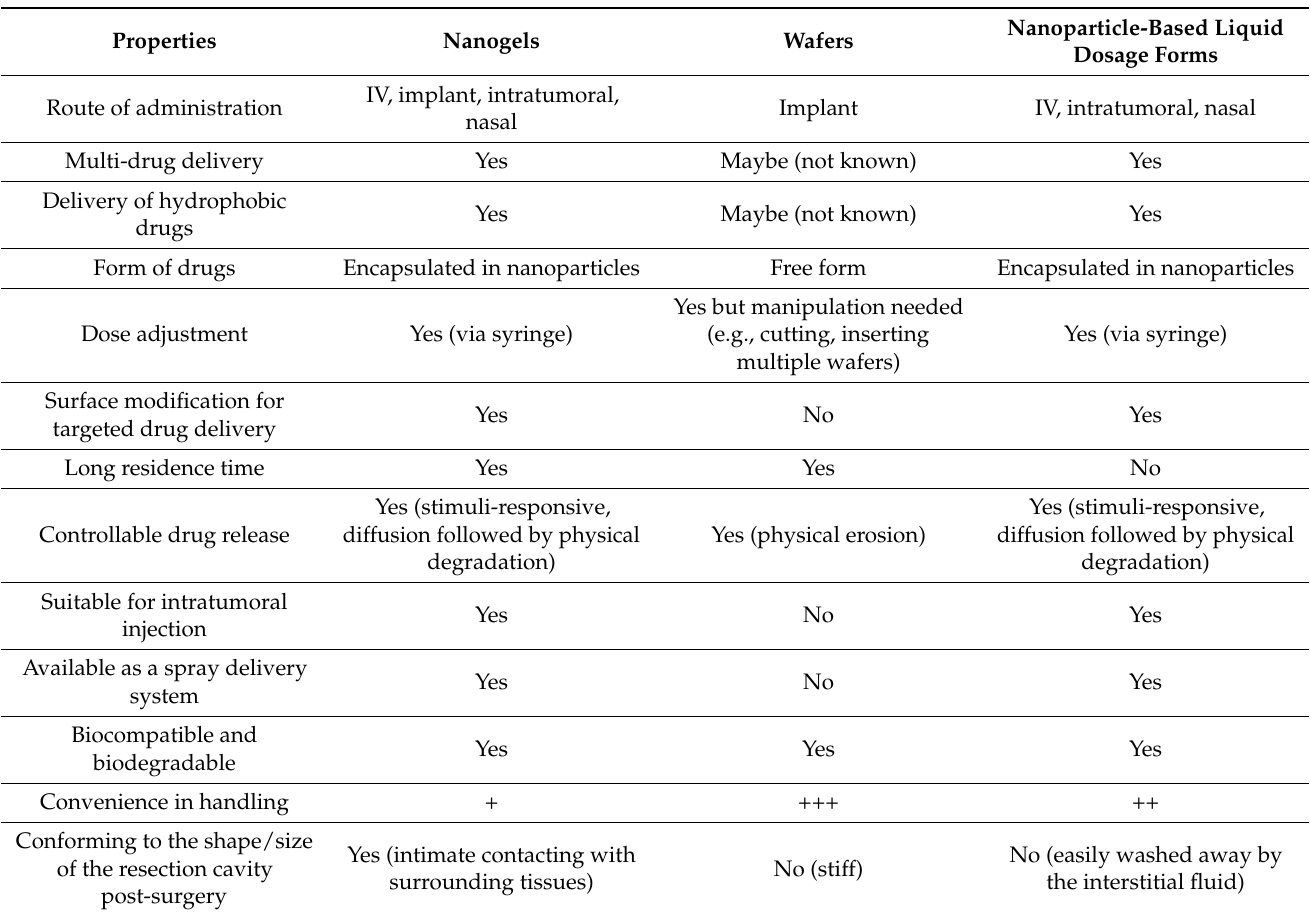
Table 2. Comparison of nanogels, wafers, and liquid dosage forms for their properties as drug delivery systems for brain